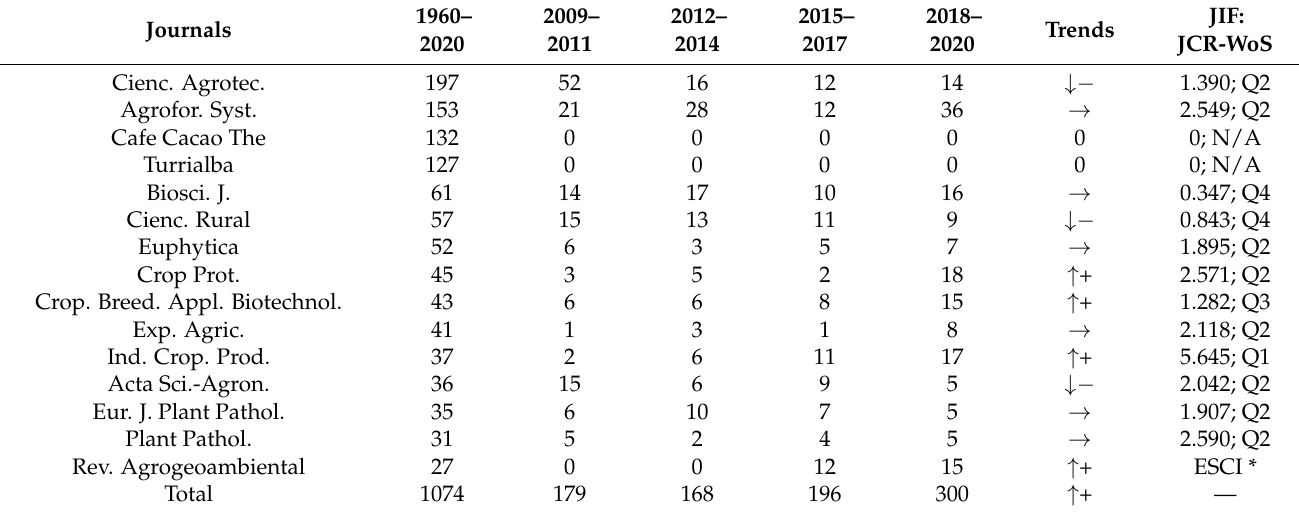
Table 2. Journals from major Bradford zones (1960–2020 and 2009–2020).